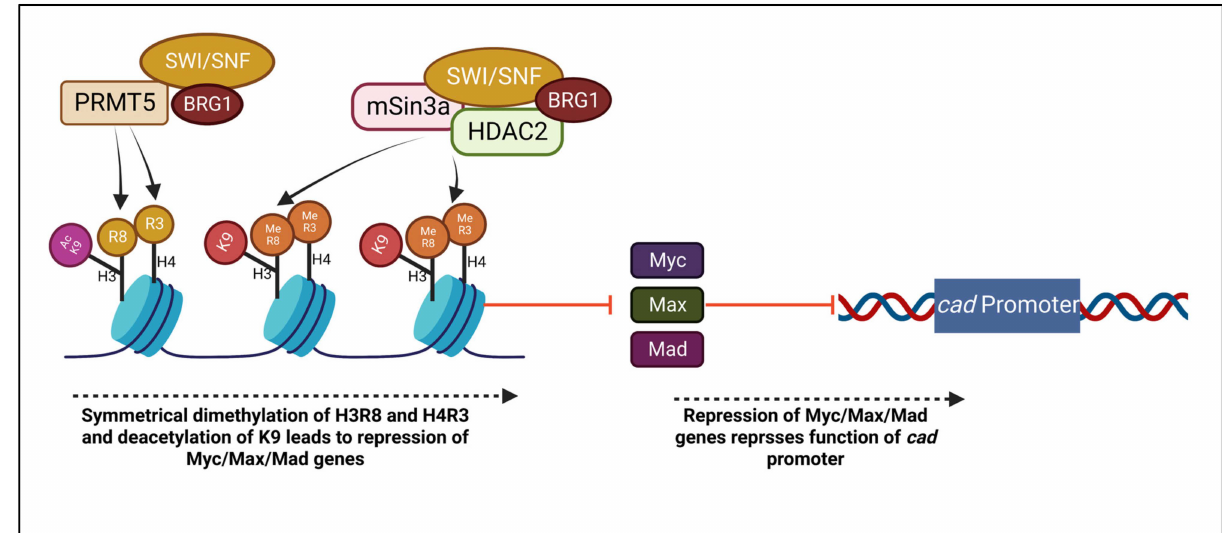
Figure 3. Histones H3R8 and H4R3 are symmetrically dimethylated, while K9 is deacetylated through PRMT5 and BRG1 association. A complex of PRMT5, BRG1, mSin3a, and HDAC2 repress Myc/Max/Mad genes, leading to additional suppression of cad